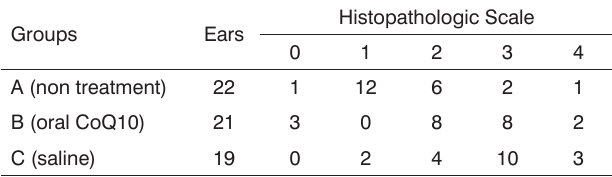
Table 3. The findings of histopathologic examination of